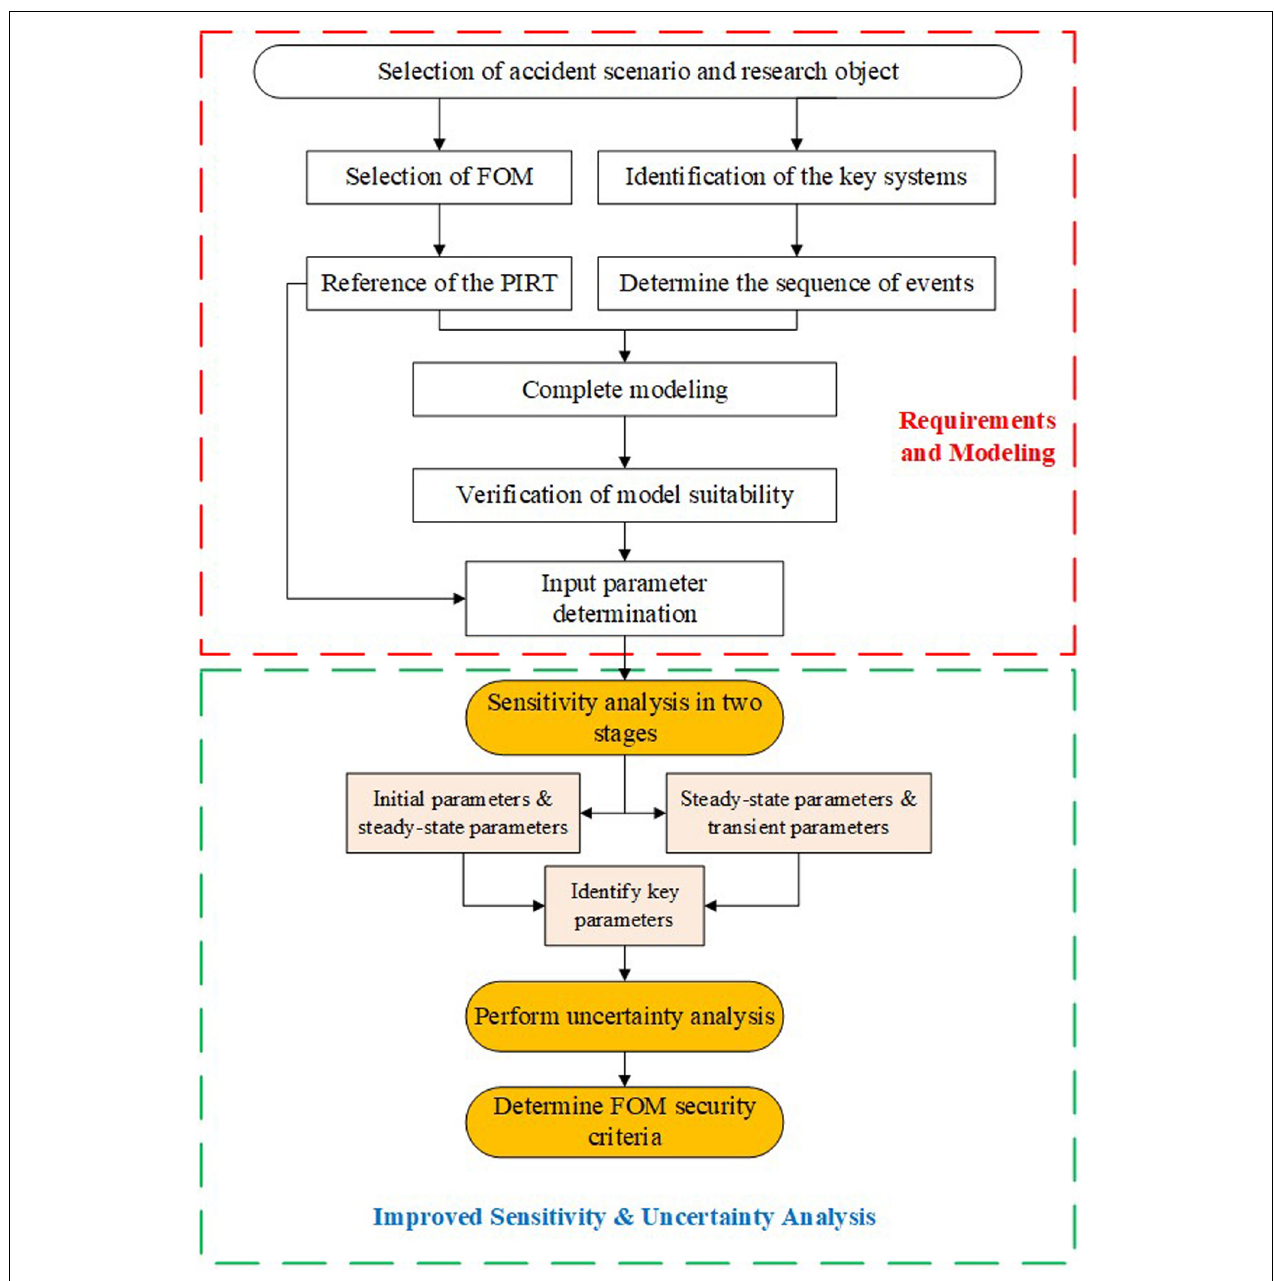
FIGURE 2 | The framework of the improved best estimate plus uncertainty analysis (BEPU)